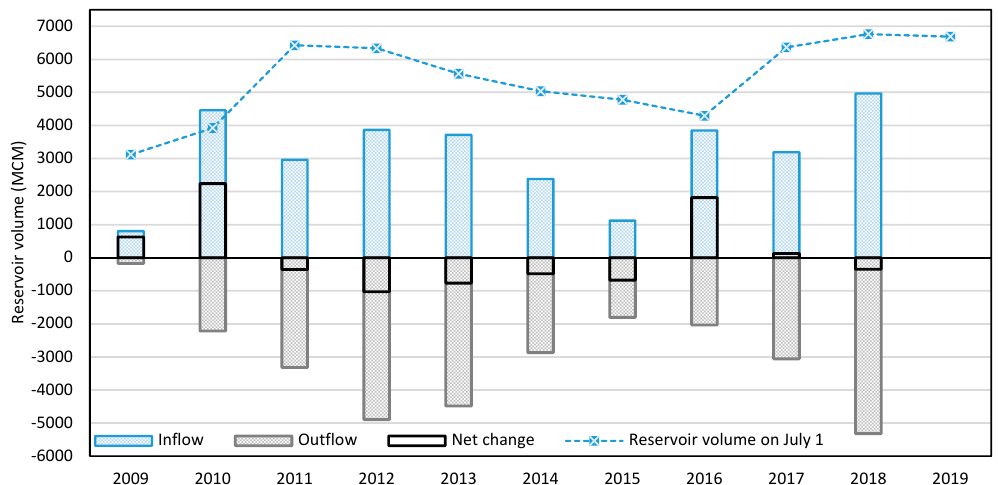
Figure 9. Yearly reservoir volume inflow and outflow, with corresponding net volume change from July 2009 to November 2019 (Data sources: [37,39,40]).